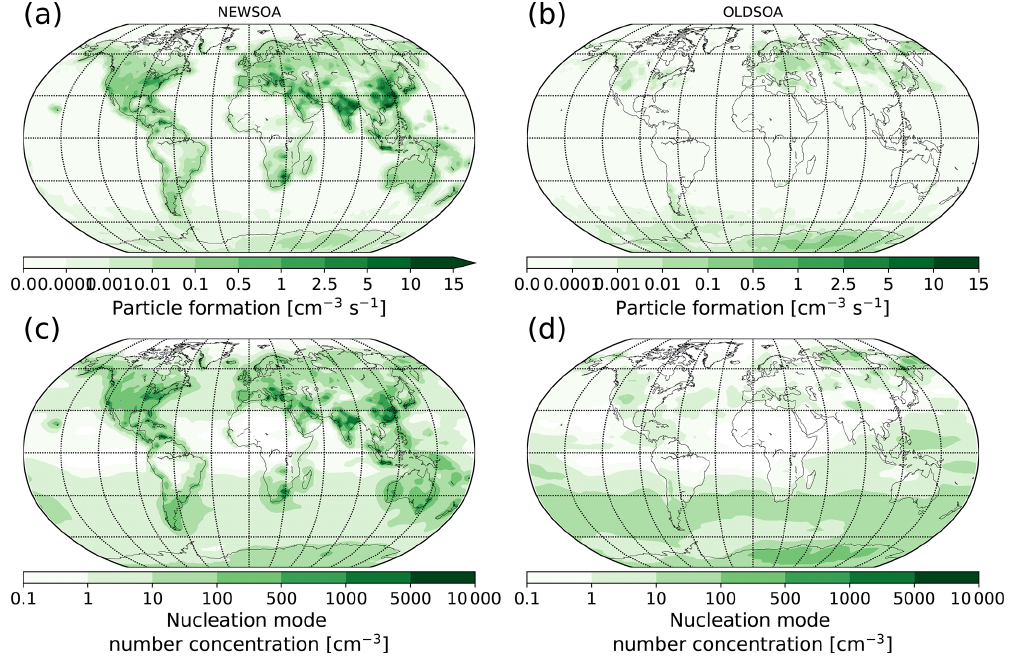
Figure 7. Modelled annual mean new particle formation rates at the surface are shown in the top row for the runs NEWSOA (a) and OLDSOA (b) . The bottom row shows the surface layer concentration of particles in the nucleation mode in runs NEWSOA (c) and OLDSOA (d) .